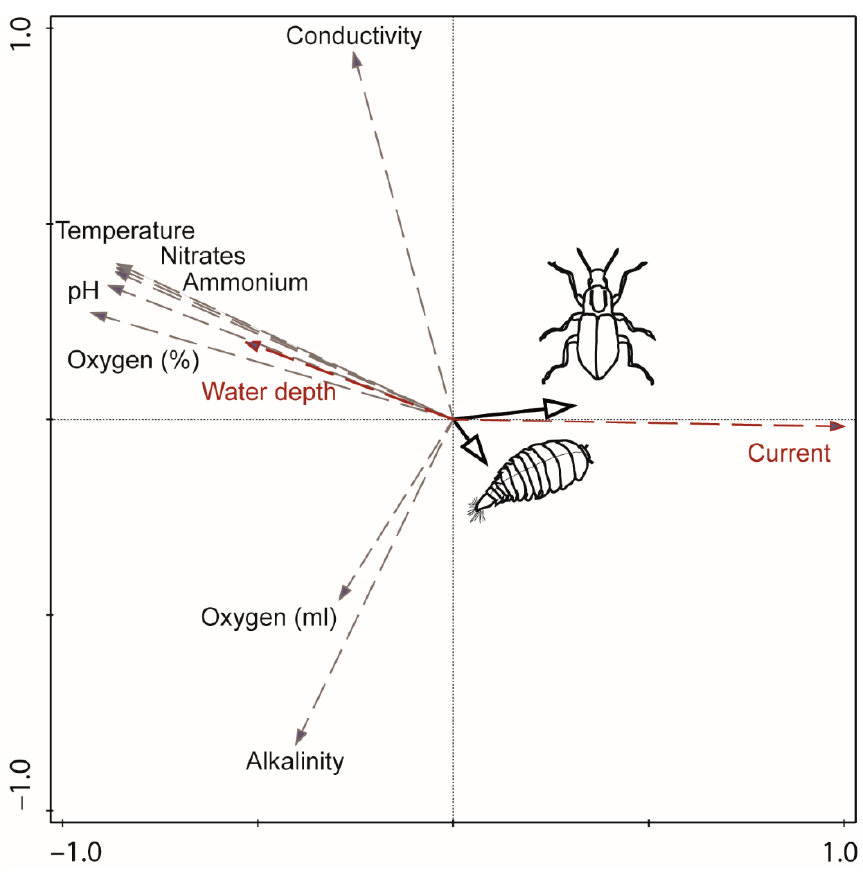
Figure 7. PCA ordination plot of Elmis bosnica Zaitzev, 1908, and environmental variables in the Spring of the Bistrica River, Bosnia and Herzegovina. Variables that significantly affect the species are marked in red. Dashed arrows represent variables, and solid arrows represent life stages.